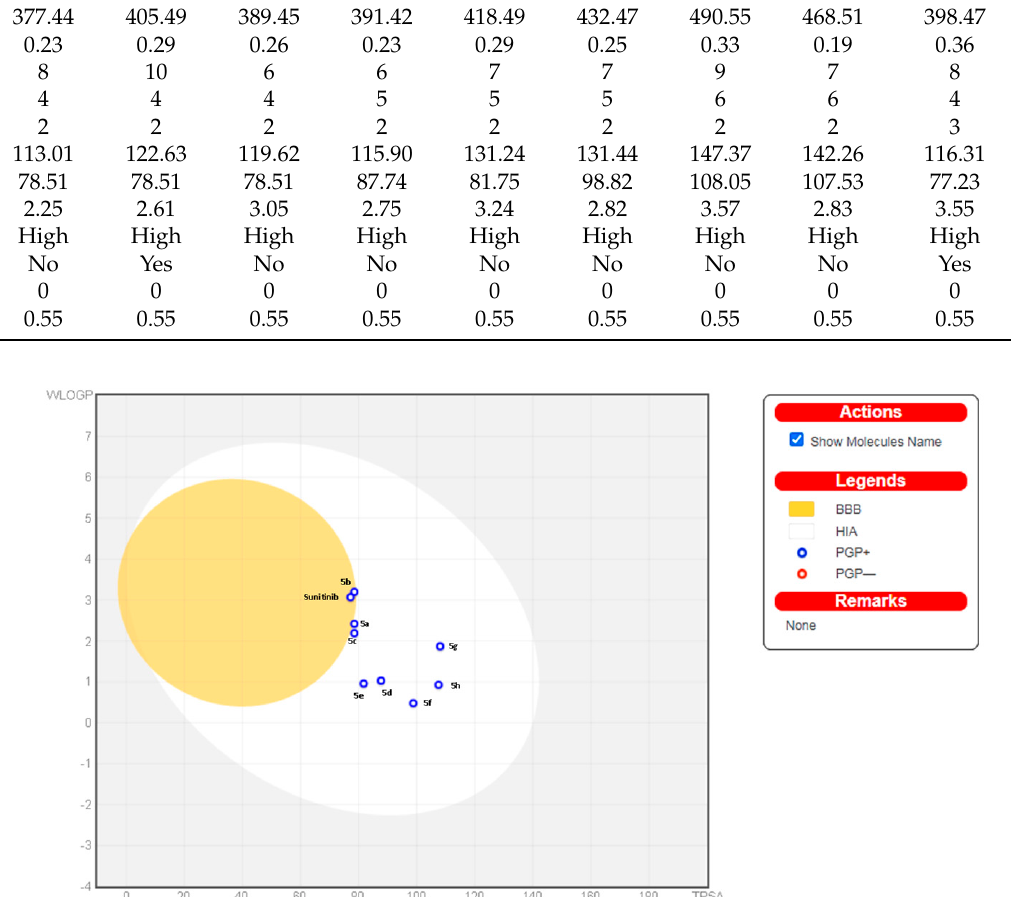
Figure 7. BOILED-Egg depiction of the synthesized compounds and sunitinib.